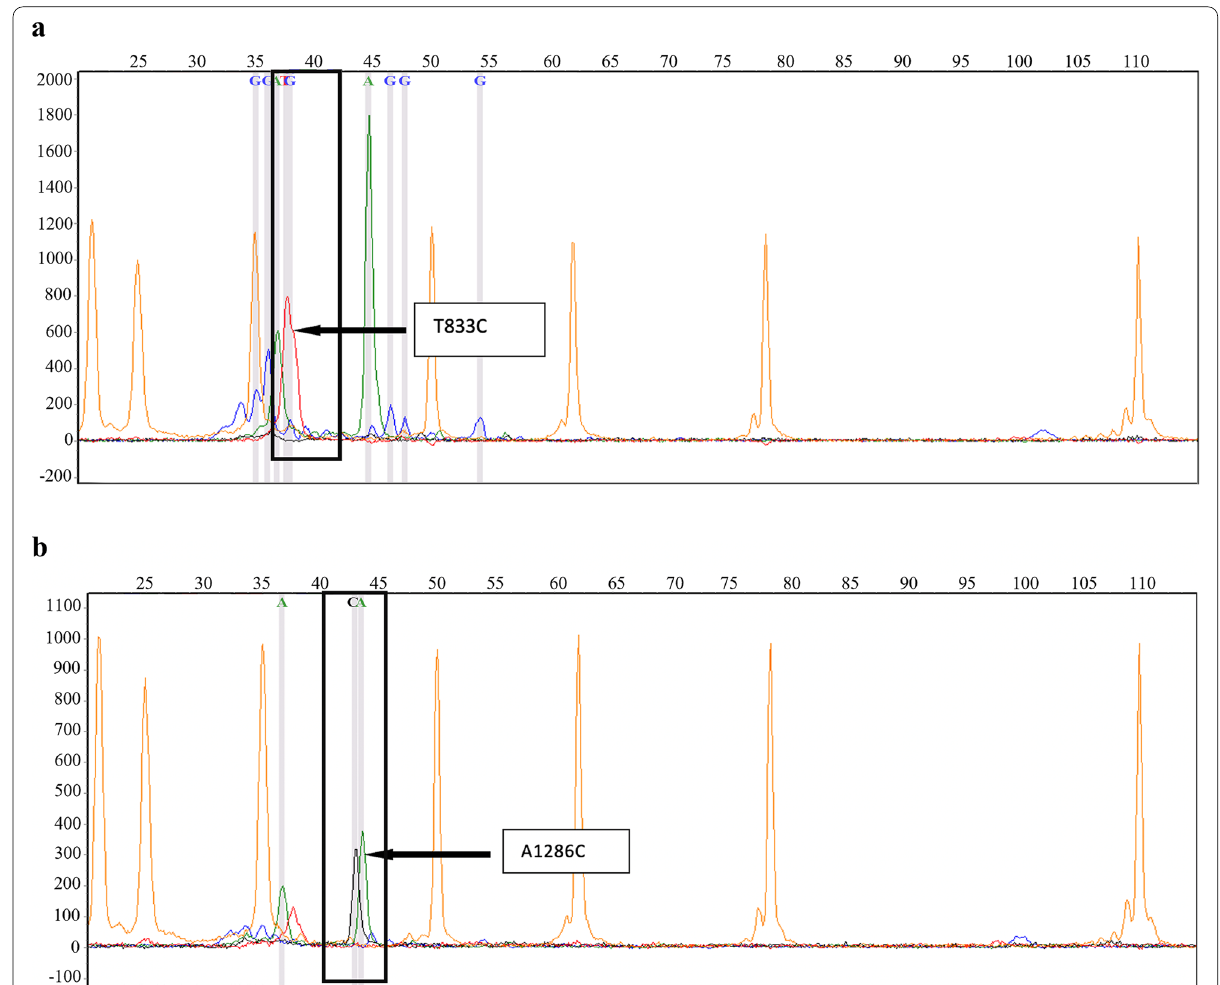
Fig. 1 GeneMarker software image of the SNP mini-sequencing result for all samples. a Electropherogram is indicated the position of the expected variant c.833T>C. b Electropherogram is indicated as the position of the expected variant